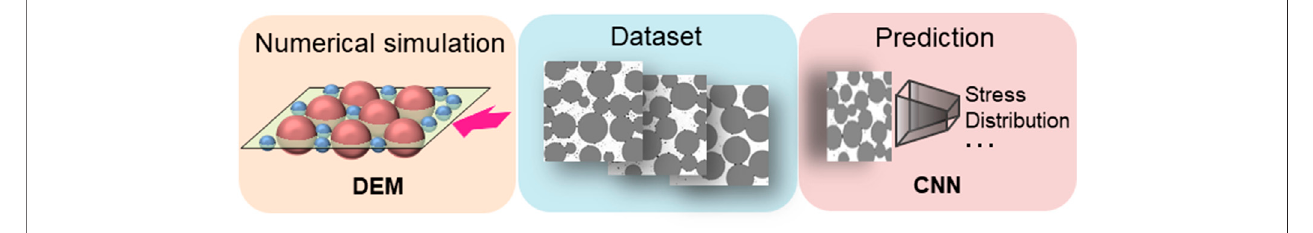
FIGURE 1 | Schematic image of concept of this